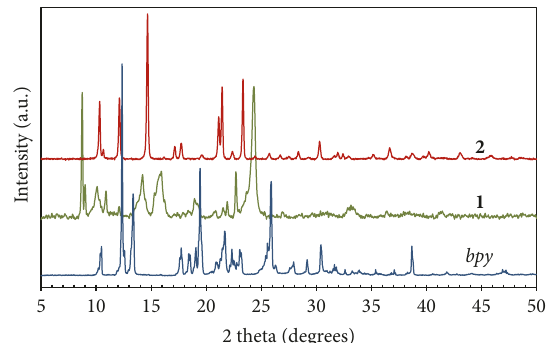
Figure 4: X-ray powder diffractograms of 1 and 2 . The mixture of 1 and bpy phases is not observed in the polymer diffraction pattern.